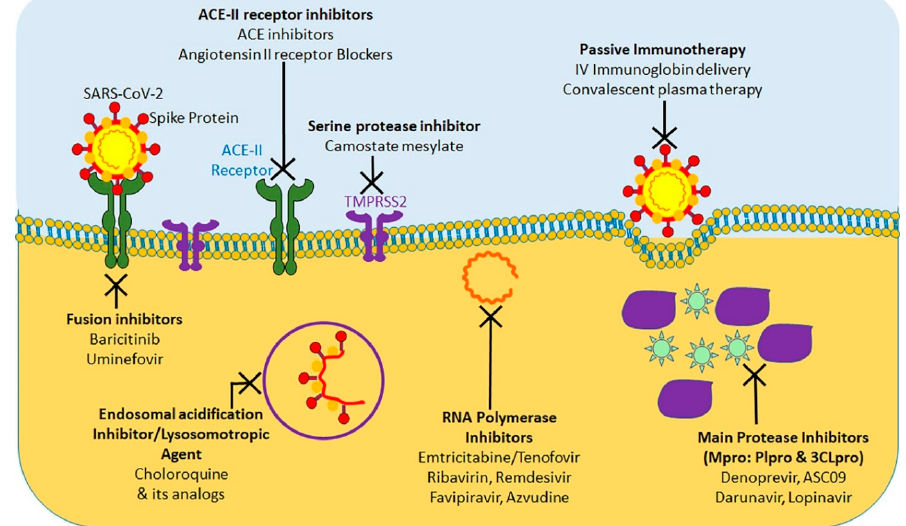
Figure 4. Summary of currently tested potential therapeutic agents targeting different steps of SARS-CoV-2 life cycle.